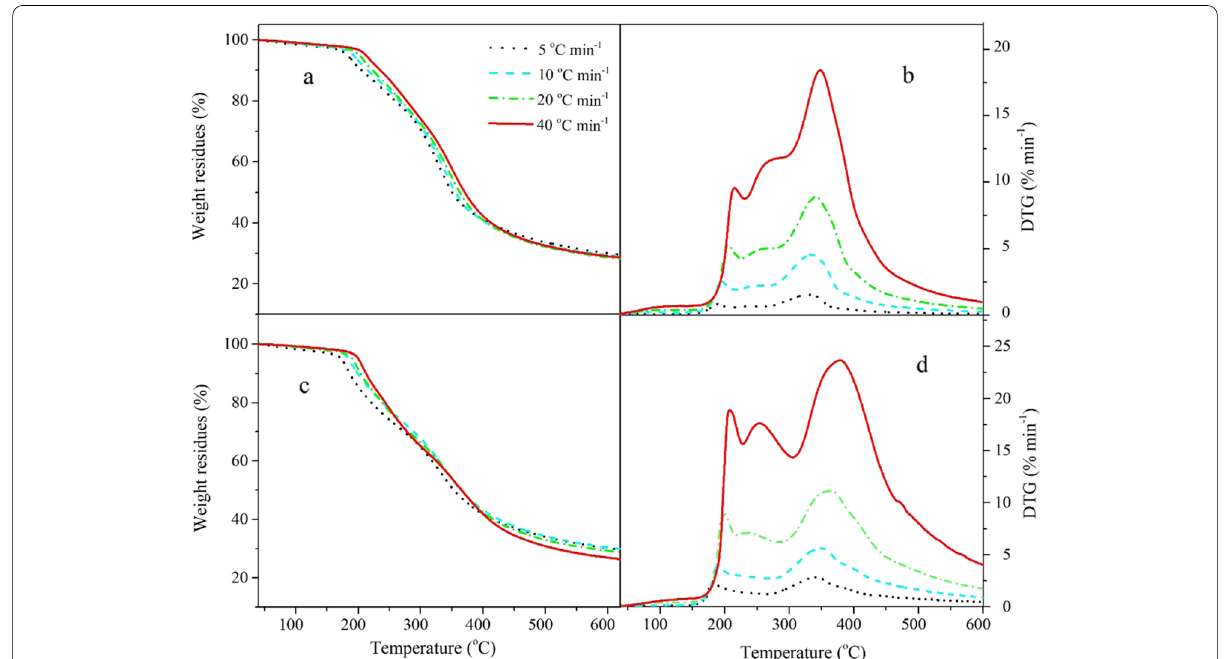
Fig. 6 TG and DTG curves of spherical CNC ( a , b ) and rod-like CNC (CNC30) ( c , d